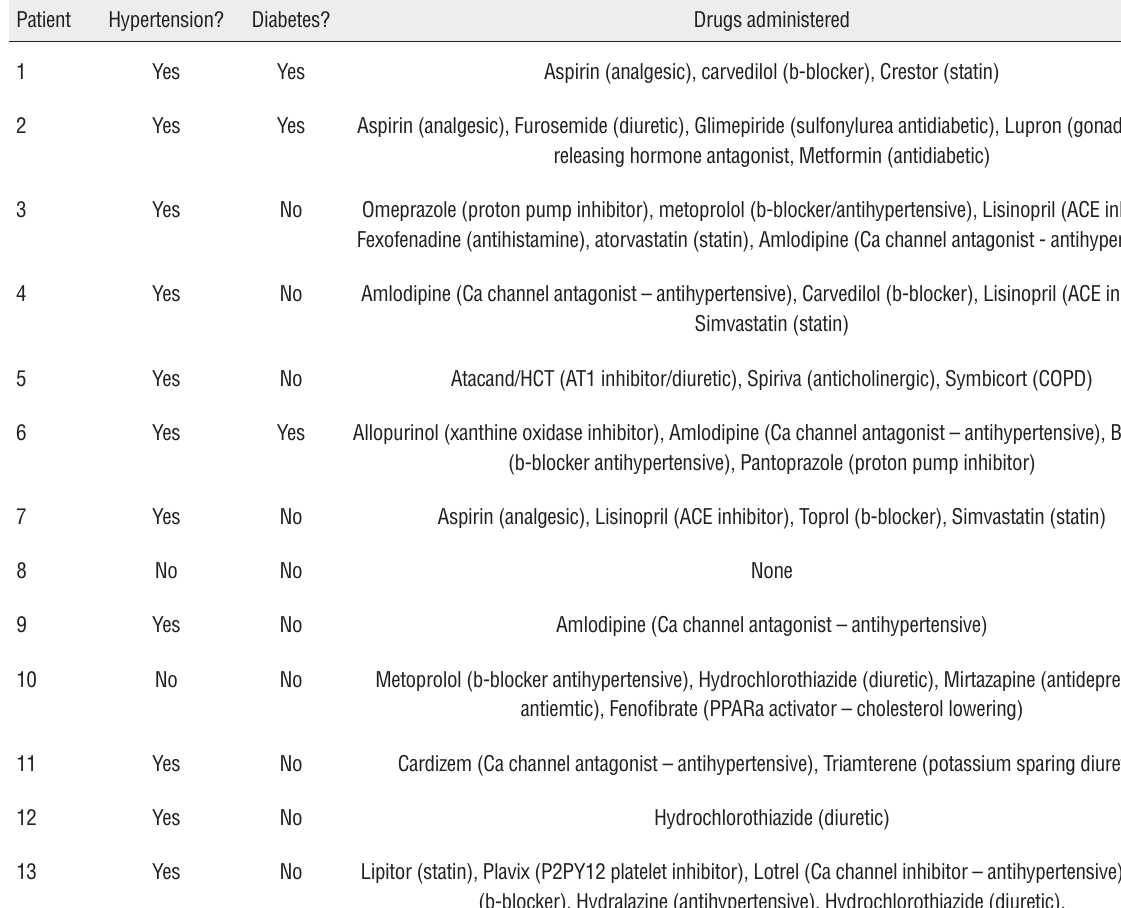
Table 4 - Patient comorbidities and administered